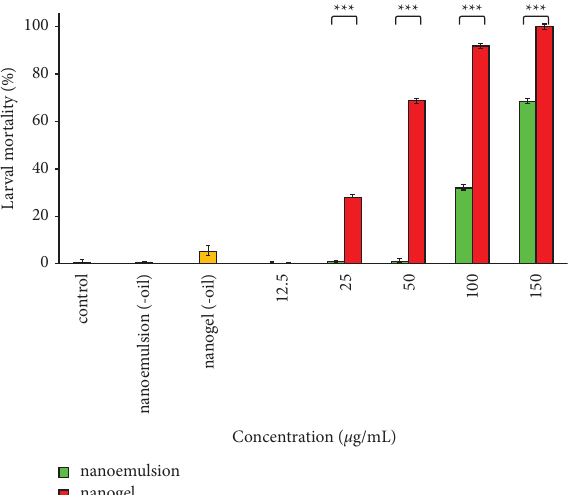
Figure 8: Larvicidal impacts of the nanoemulsion and nanogel containing C. cyminum EO against A . stephensi ; ∗∗∗ P < 0 .